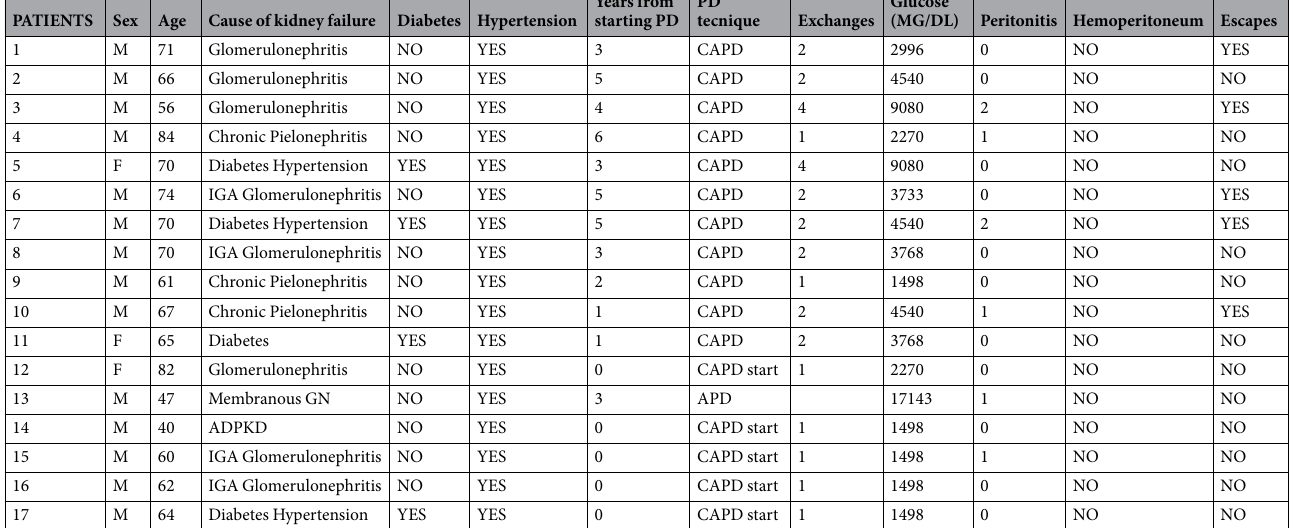
Table 1. Baseline clinical data of patients enrolled in this